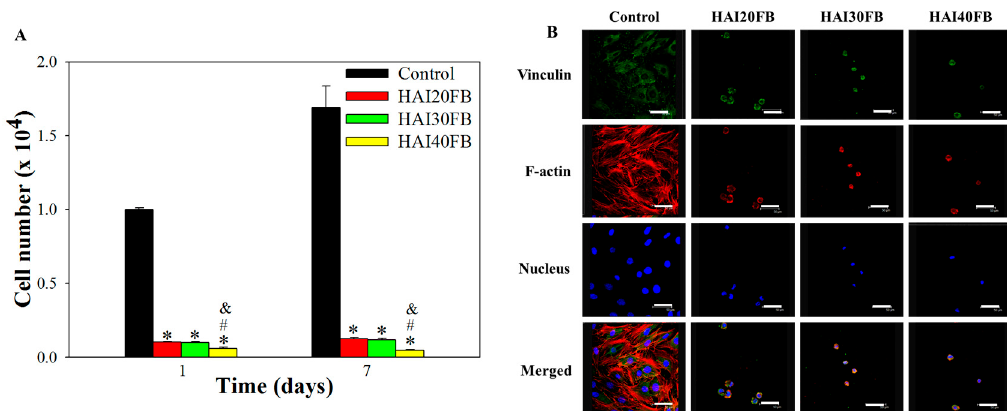
Figure 7. ( A ) Attachment and proliferation of 3T3 fibroblasts on TCPS (control) and HAI20FB, HAI30FB, and HAI40FB NFMs from assays of DNA contents. ( B ) The cytoskeletal arrangement and focal adhesion protein expression of 3T3 fibroblasts after cell seeding for 24 h were determined by actin cytoskeleton and vinculin staining and observed by confocal microscopy. Vinculin focal adhesion, actin cytoskeleton, and cell nucleus are shown in green, red, and blue, respectively. Bar = 50 mm. * p < 0.05 compared with control; # p < 0.05 compared with HAI20FB; & p < 0.05 compared with HAI30FB.